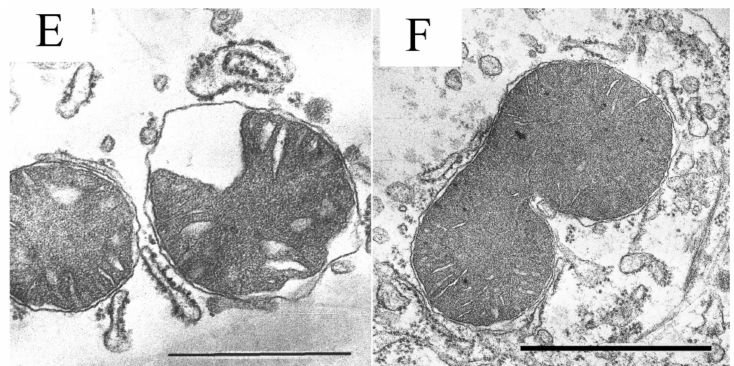
Figure 2. Transmission electron micrographs of typical liver mitochondria of mice of four experimental groups: CTR ( A ), CTR + S-15176 ( B ), T2DM ( C , E ) and T2DM + S-15176 ( D , F ). Samples from two livers were analyzed in each experimental group. The number of examined fields of view (25 µ m 2 ) in the groups varies from 15 to 25. The number of mitochondria analyzed in each group varies from 100 to 200. The bar is equal to 1 µ m ( A – D ) or 0.5 µ m ( E , F